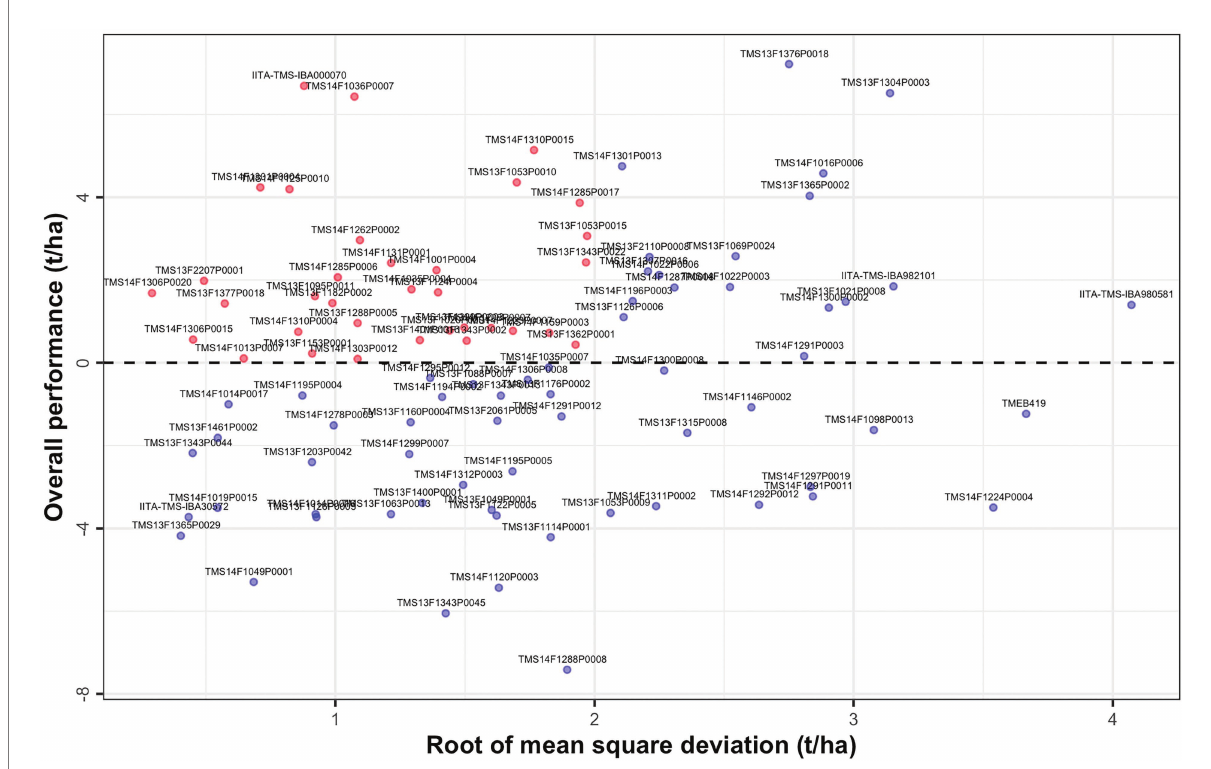
FIGURE 3 Overall performance (OP) vs. stability (Root of mean square deviation, RMSD) for fresh root yield showing all 96 clones evaluated across the environments.